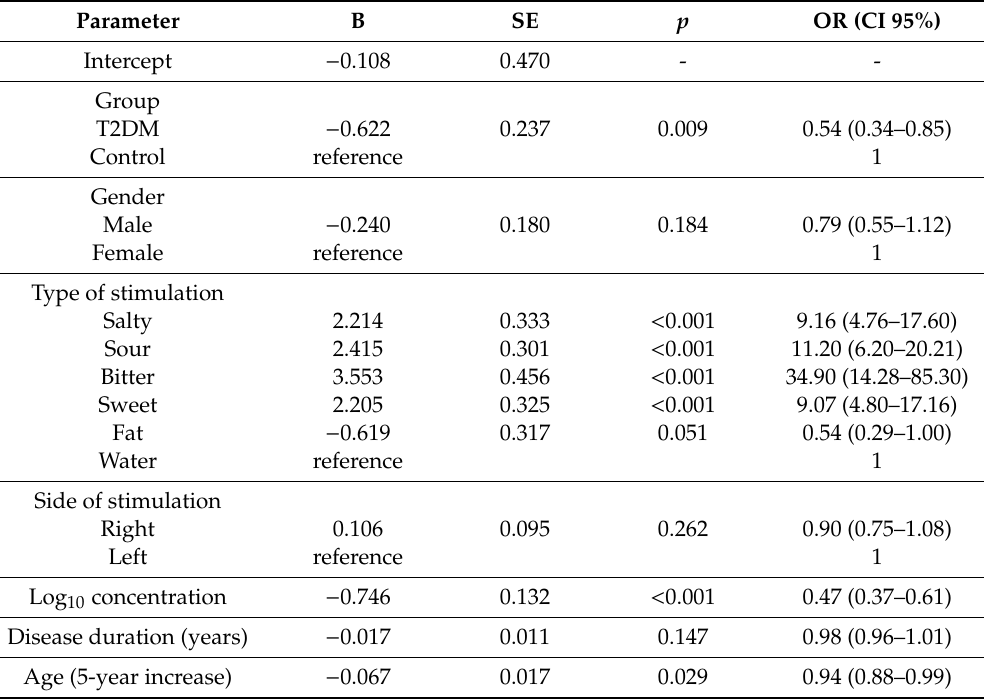
Table 3. Generalized estimated equations